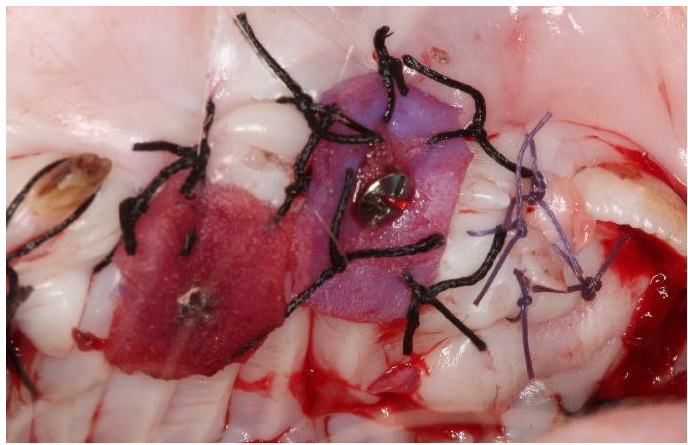
Figure 2. Acellular dermal matrix (center) and subepithelial autologous connective tissue graft (left) placed in surgical beds.